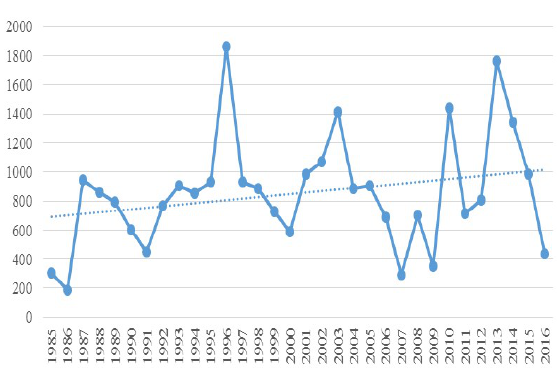
Figure 3. Average annual temperature of Tomur from 1985 to 2016 (0.1 ℃ )